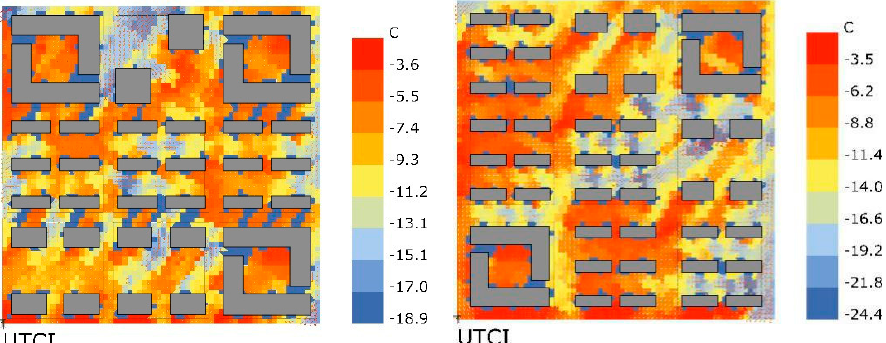
Figure 6. Example optimization results at block level: the best optimization (left, street width: 20 m, acceptable UTCI percentage: 87.7%) and the worst optimization (right, street width: 40 m, acceptable UTCI percentage: 73.6%).